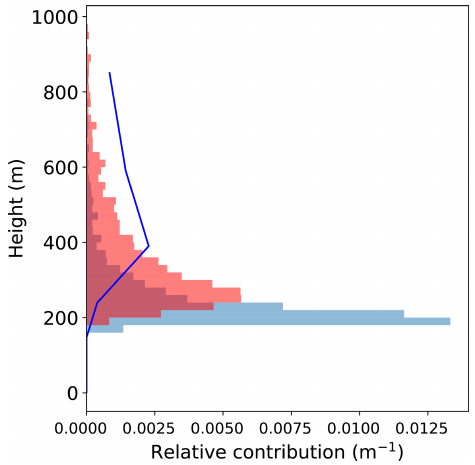
Figure 4. Normalized histogram of plume altitude above ground at the Jänschwalde power plant in winter (blue) and summer (red). The blue line shows the EMEP standard profile for power plants for comparison. Areas below the curves integrated along the vertical axis are normalized to